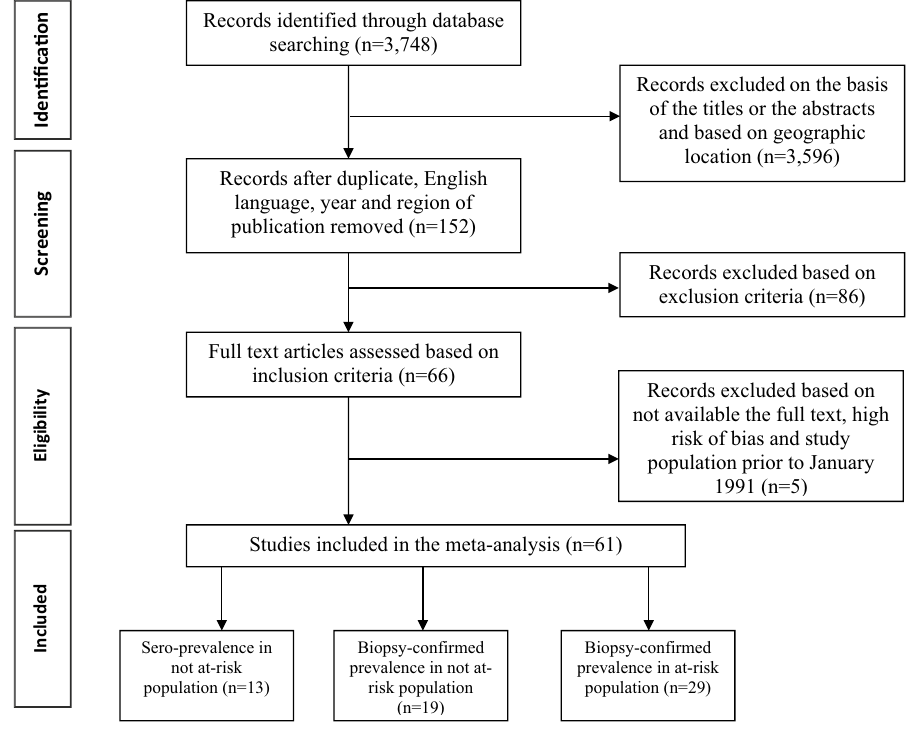
Figure 1. PRISMA flowchart of selecting the